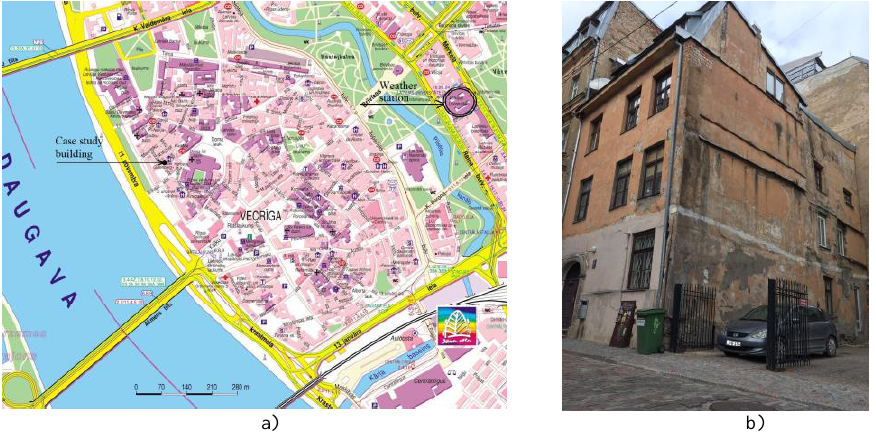
Fig. 1. Case study at Biskapa gate 6: a) location of building and weather station in map; b) façade of the building